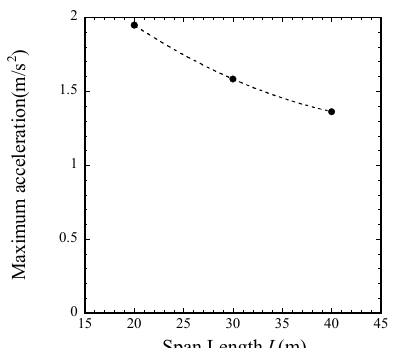
Fig. 13 Hub height maximum acceleration dependency on L ( D p : H p = 6 m: 23 m, T 0 = 2290 kN, under cut-out wind speed conditions, – 90°).